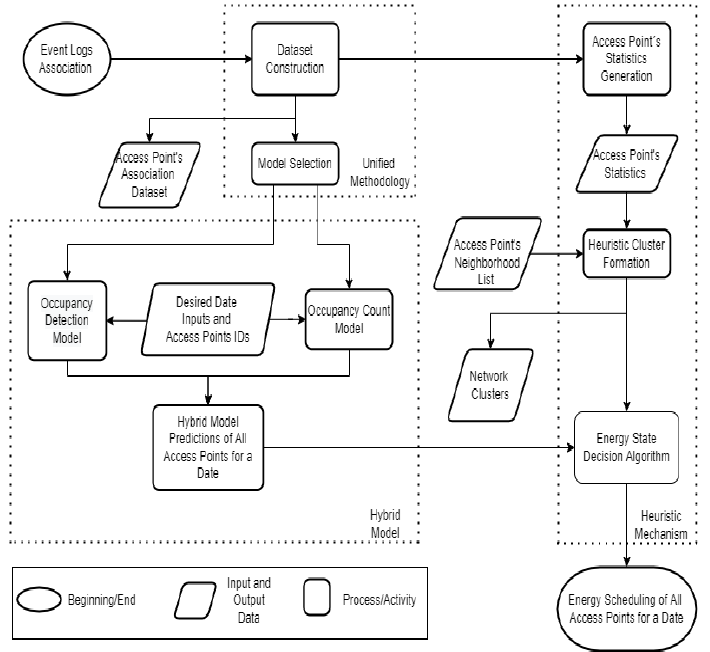
Figure 1. eSCIFI